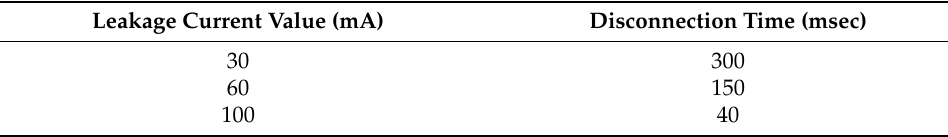
Table 1. Leakage current limits and their corresponding disconnection times according to VDE 0126-1-1 standard [19].